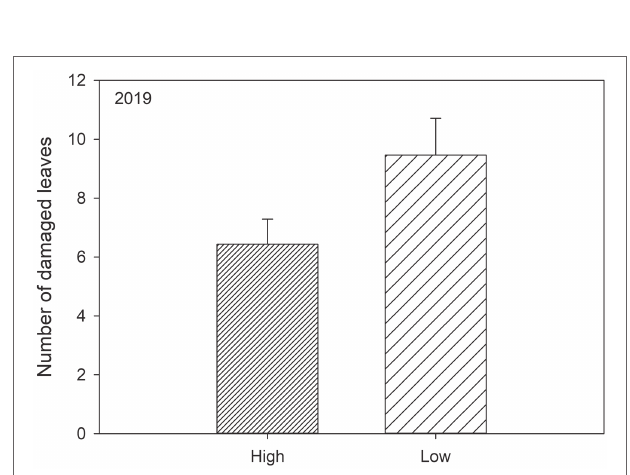
FIGURE 3 | Significant effects ( Table 2 ) of genetic diversity (high, i.e., 10 varieties and low, i.e., 2 varieties) on the number of herbivore damaged leaves of susceptible woodland strawberry ( Fragaria vesca ) plants in 2019.